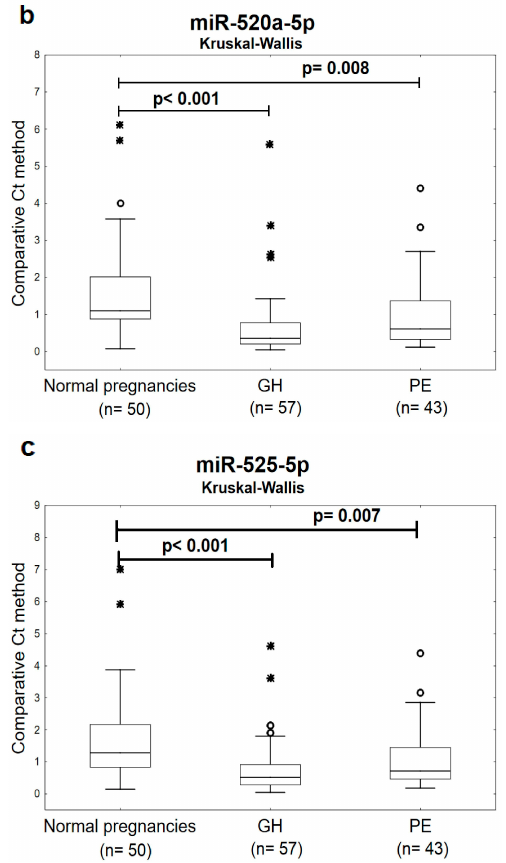
Figure 1. Down-regulation of miR-517-5p, miR-520a-5p, and miR-525-5p in plasma exosomes